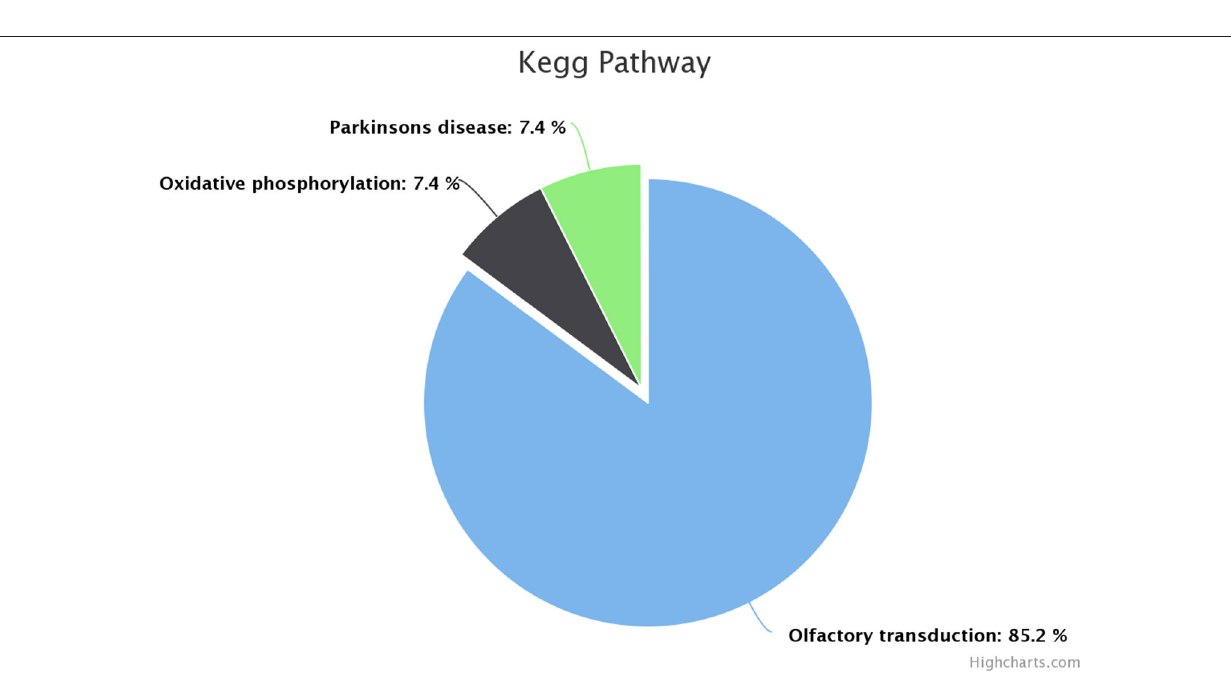
FIGURE 3 | Kyoto Encyclopedia of Genes and Genomes (KEGG) pathway enrichment of dysregulated genes.